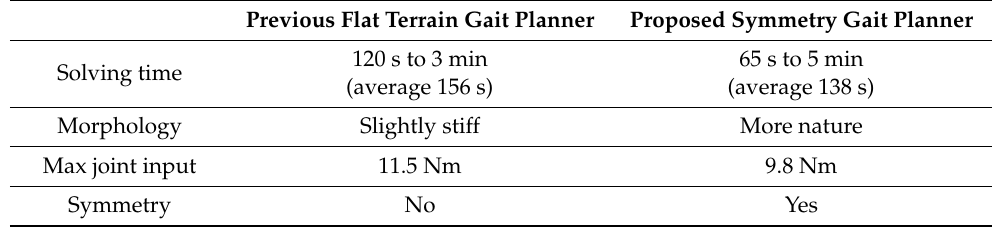
Table 4. c between two